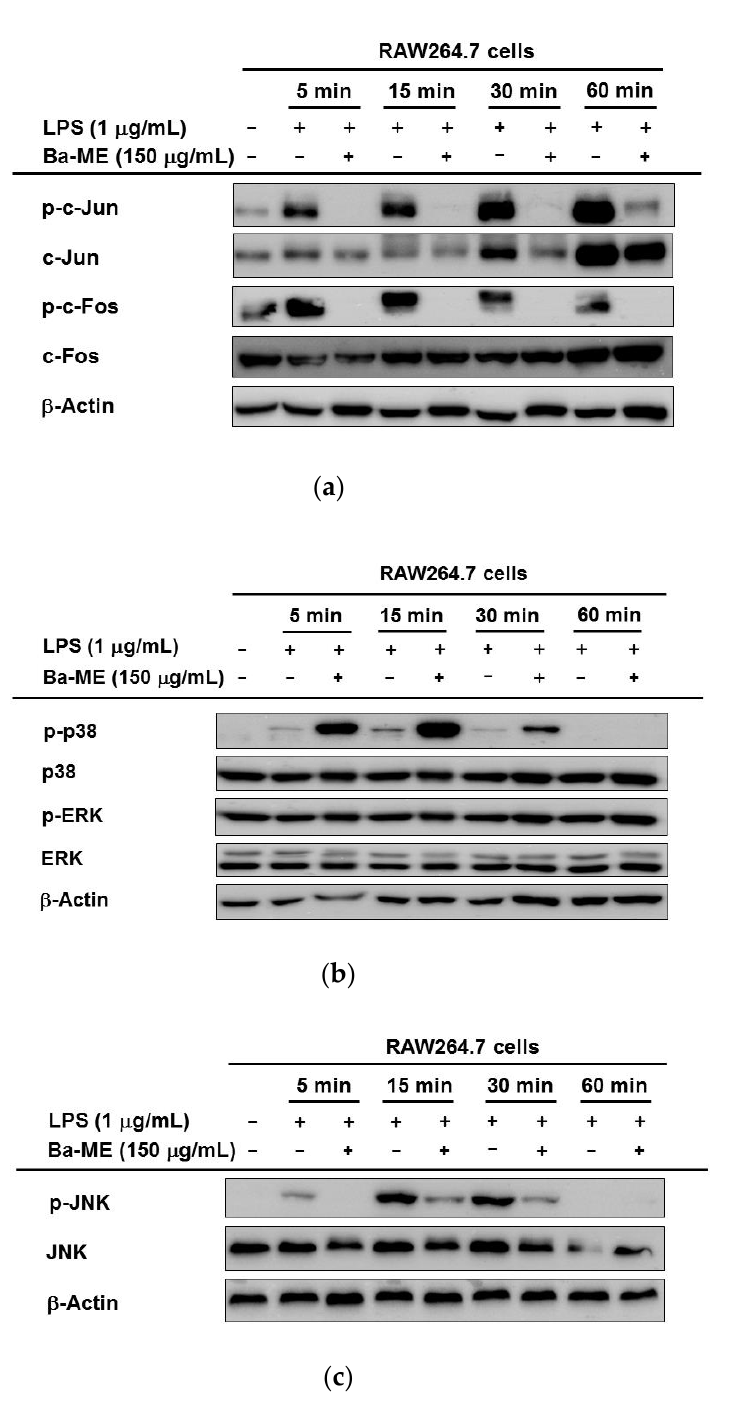
Figure 3. Effect of Ba-ME on intracellular signaling molecules’ activation in the AP-1 pathway. ( a – c ) Treated RAW264.7 cells with LPS (1 µ g/mL) for 5, 15, 30, 60 min in the absence or presence of Ba-ME (150 µ g/mL). A Western blot analysis determined the levels of phosphorylated forms and total forms of c-Jun and c-Fos ( a ). Using an immunoblot analysis of cell lysates to determine the phosphoprotein levels of p-38, ERK, JNK, and β -actin ( b , c